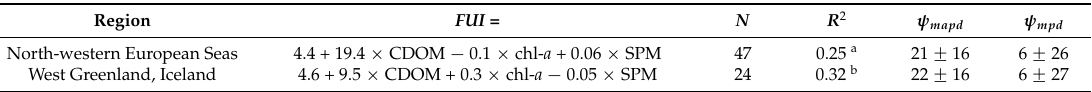
Table 1. Multivariate linear regressions linking Forel–Ule colour Index (FUI) to coloured dissolved organic matter (CDOM), chlorophyll- a (chl- a ), and non-algal particles (SPM). Regression statistics are number of available matching points ( N ), regression coefficient ( R² ), mean absolute percent difference ( ψ mapd ), and mean percent difference ( ψ mpd